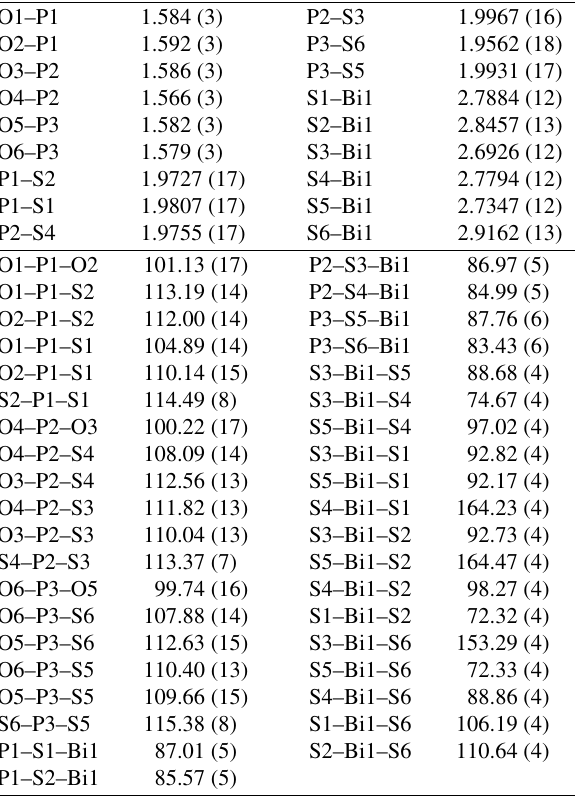
Table 2. Selected bond lengths (Å) and angles (°) for [{ (3,5- CH